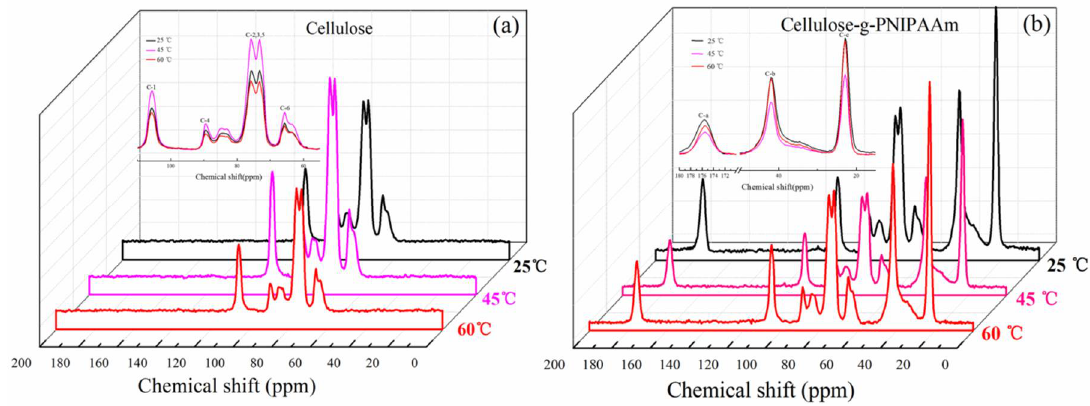
Figure 9. The in situ variable-temperature 13 C solid-state Nuclear Magnetic Resonance spectra of cellulose ( a ) and cellulose- g -PNIPAAm ( b ) in different temperature conditions of 25 °C, 45 °C and 60 °C.